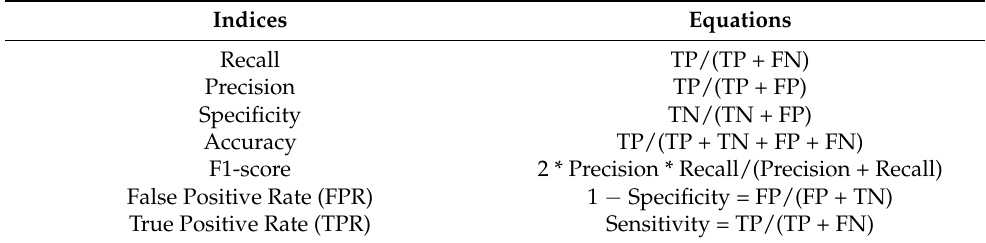
Table 3. The confusion matrix-based accuracy evaluation equations used throughout this study. Indices